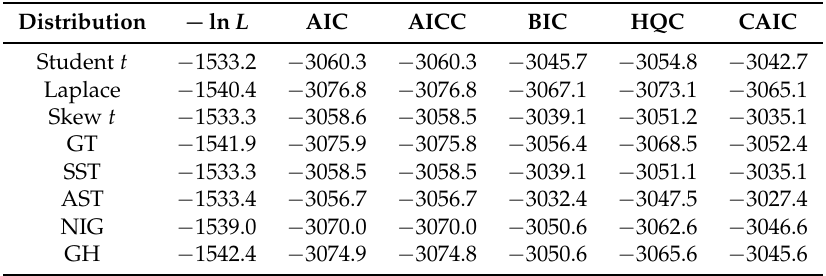
Table 8. Fitted distributions and results for daily log returns of the exchange rates of MaidSafeCoin